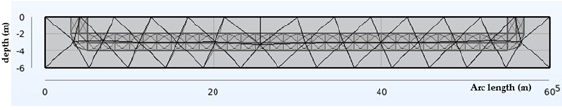
Fig. 7. Longitudinal view of the buried pipe inside soil mass